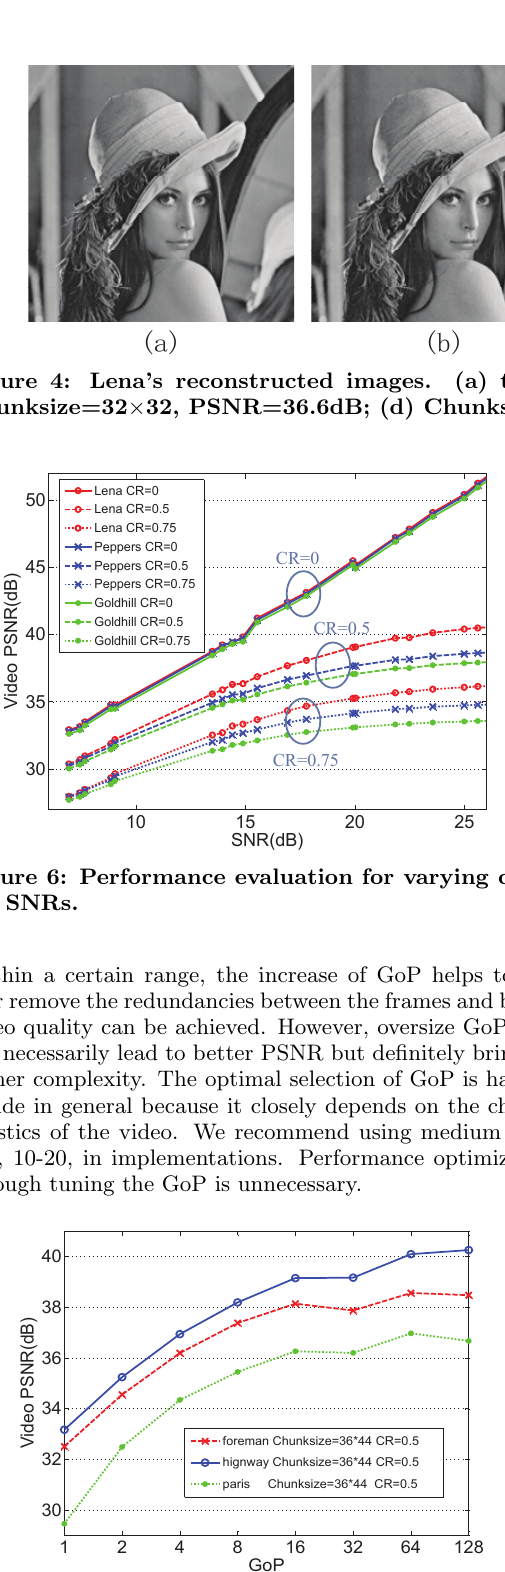
Figure 7: Performance evaluation for different GoPs.